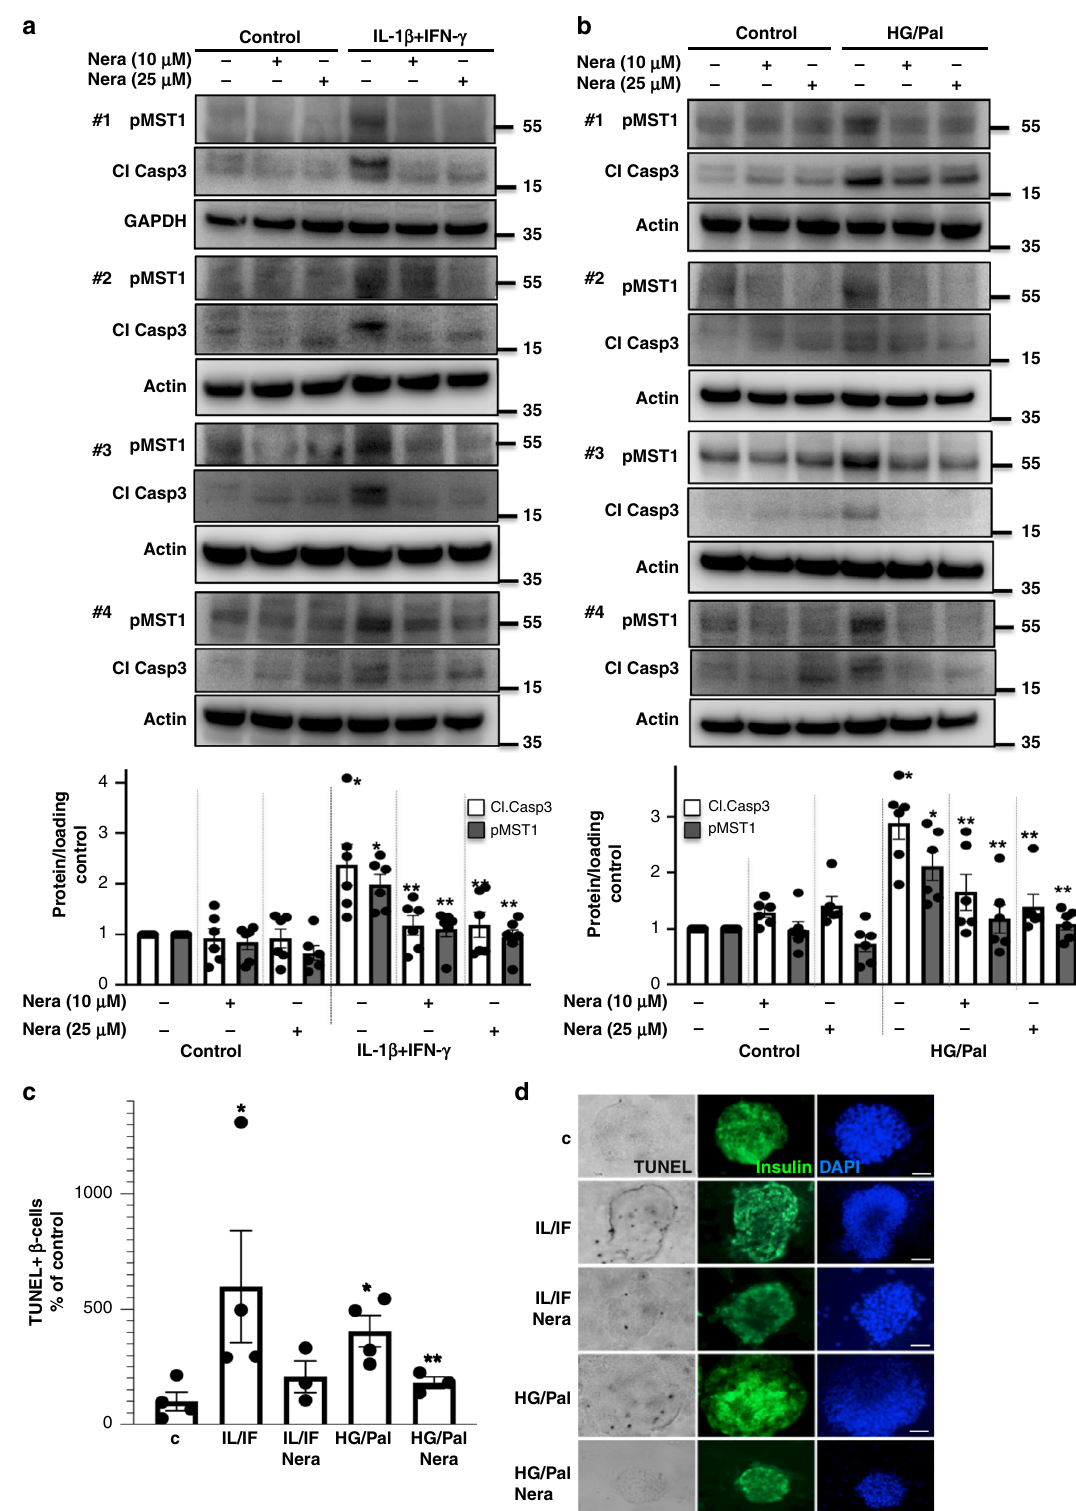
Fig. 3 Neratinib blocks MST1 activation and apoptosis in human islets. Human islets were exposed to diabetogenic conditions ( a , c , d IL-1 β /IFN γ , b – d mixture of 22.2 mM glucose and 0.5 mM palmitate (HG/Palm)) ± neratinib for 72 h. a , b Phospho-MST1 (pMST1; pThr183), caspase-3 cleavage, and GAPDH or actin were analyzed by western blotting. Representative Western blots of four different human islet donors ( a , b ; upper panels) and pooled quantitative densitometry analysis ( a , b ; lower panels) of six different human islet donors are shown ( n = 6). c , d β -cell apoptosis analyzed by triple staining of TUNEL (black nuclei), insulin (green), and dapi (blue). Scale bar, 100 μ m. An average number of 40,420 insulin-positive β -cell per condition was counted in 3 – 4 independent experiments from 3 to 4 different human islet donors ( n = 3 – 4). Results shown are means ± SEM. * p < 0.05 IL/IF or HG/Pal to control, ** p < 0.05 neratinib to vehicle-treated islets under the same diabetogenic conditions; all by Student ’ s t tests. Source data are provided as a Source Data fi